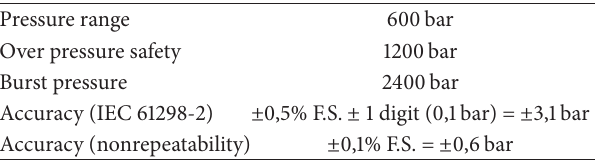
Table 3: WIKA DG-10-S digital pressure gauge technical data [10].